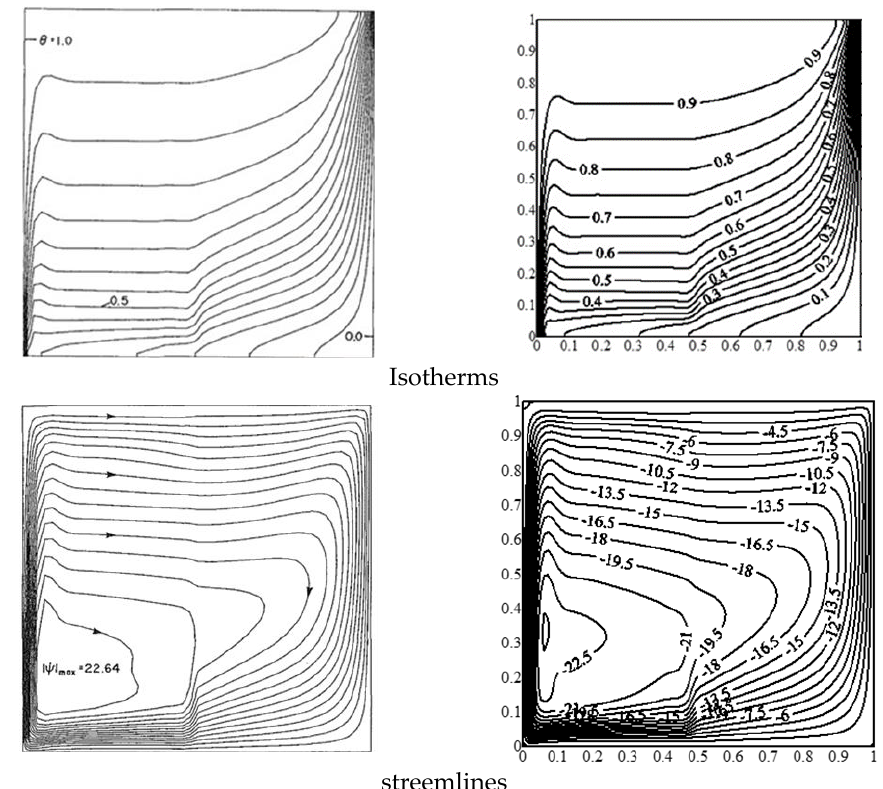
Figure 2. Comparison of the current results ( right ) and those of [43] ( left ).